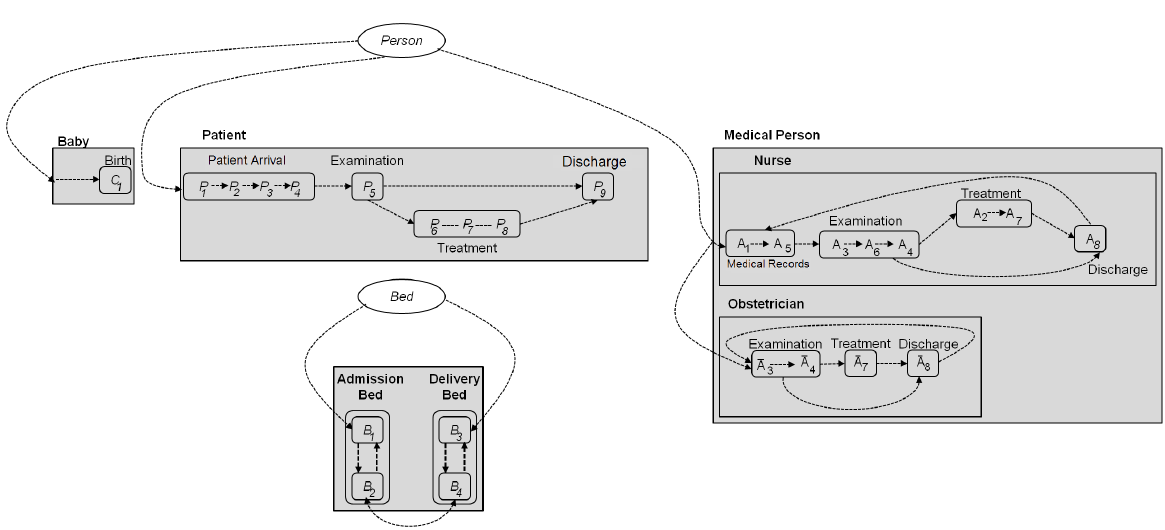
Figure 13. Decomposition levels in the ORM scheme shown in Figure